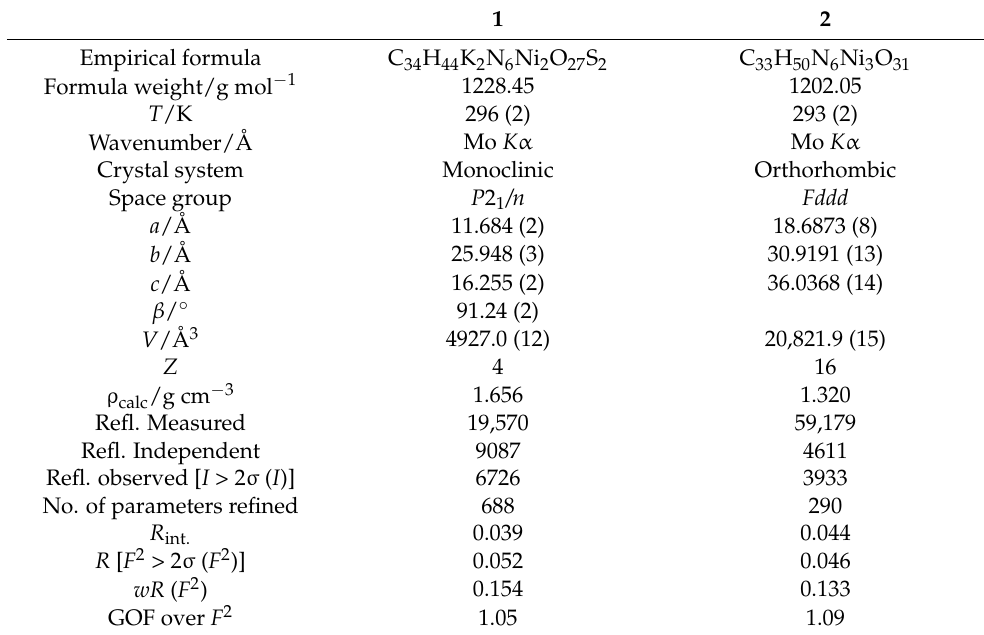
Table 1. Summary of the crystal data and structure refinement for 1 and 2